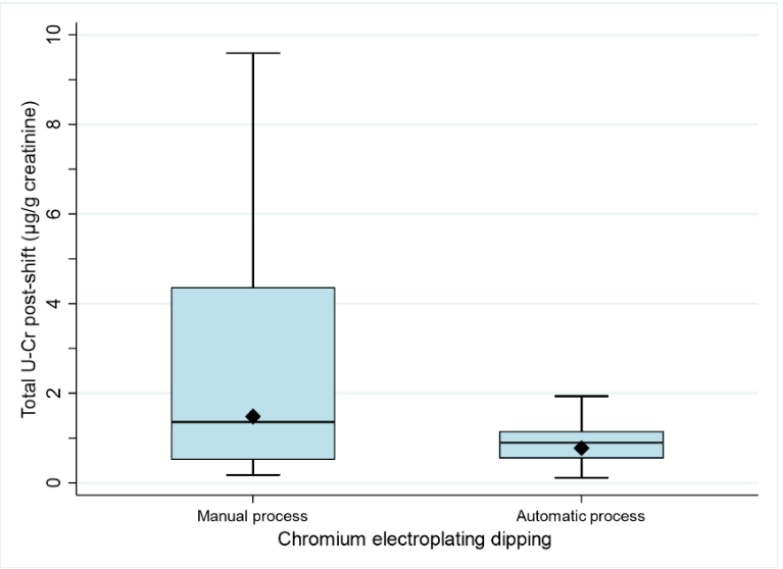
Figure 1. Levels of total urinary chromium (post-shift samples) for workers performing task “chromium electroplating dipping” by process type: manual (n = 67) or automatic n = 16). Box plots: The bottom and top of the box are, respectively, the 25th and 75th percentiles, and the horizontal line inside the box is the median (50th percentile). The lower and upper ends of the whiskers are the 5th and 95th percentiles, respectively. The solid diamond is the geometric mean.